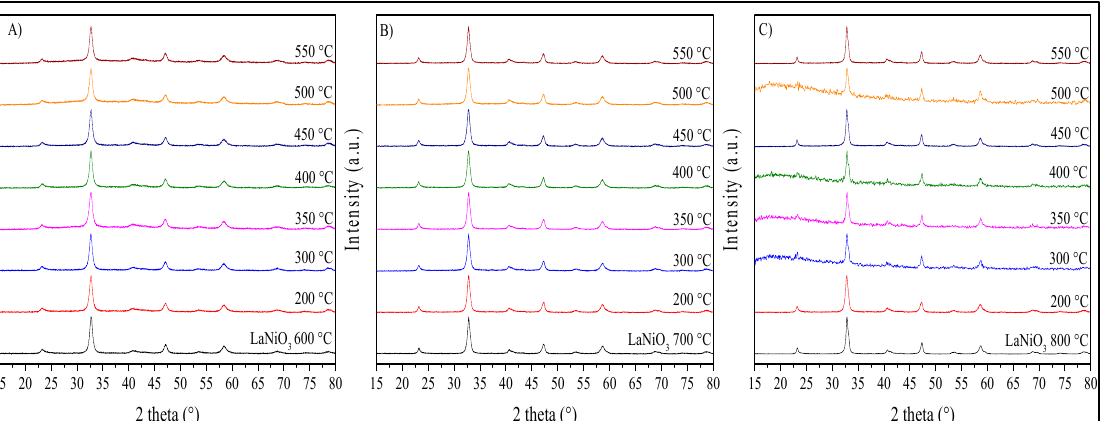
Figure 11. Isothermal analyses for the LaNiO 3 samples calcined at 600 ( A ), 700 ( B ), and 800 °C ( C ).